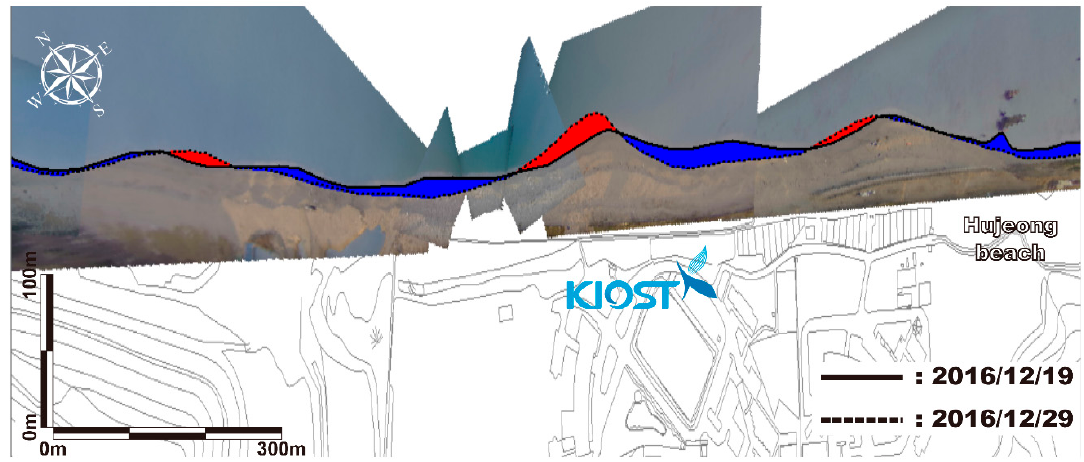
Figure 2. Comparison of shoreline positions in Hujeong Beach measured by VMS. Black solid line marks the shoreline measured on 19 December 2016 and black dashed marks the shoreline on 29 December 2016. The difference between these two lines is colored with red or blue as it denote the accretion or retreat area during the period respectively.